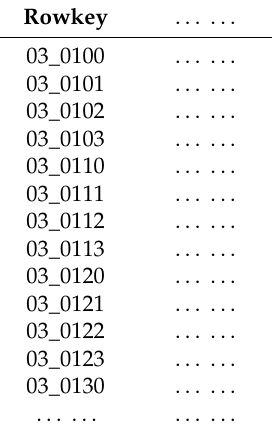
Table 3. Store schema of the hierarchical Hilbert code and level as the rowkey.